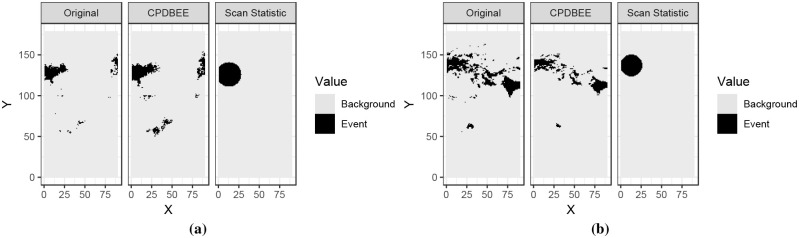
Event extraction comparison for NO2 data.